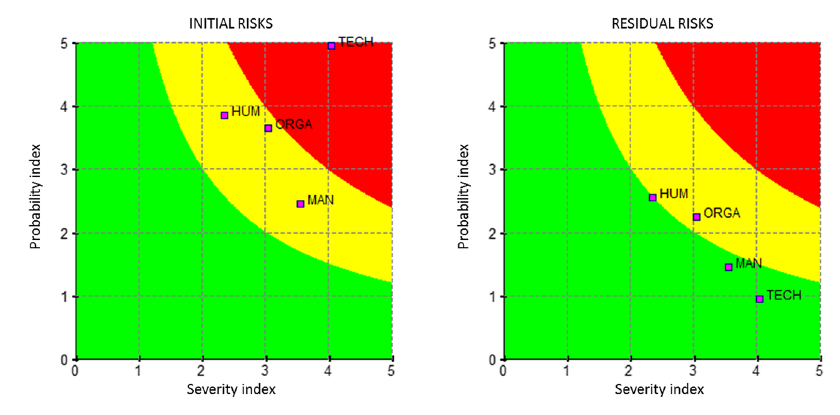
Figure 6: Farmer ’ s diagram of initial and residual risks by phase for PRA2.